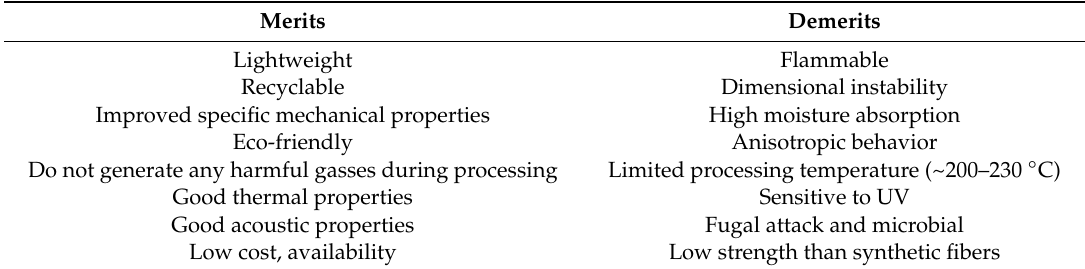
Table 3. Merits and demerits of natural fibers.